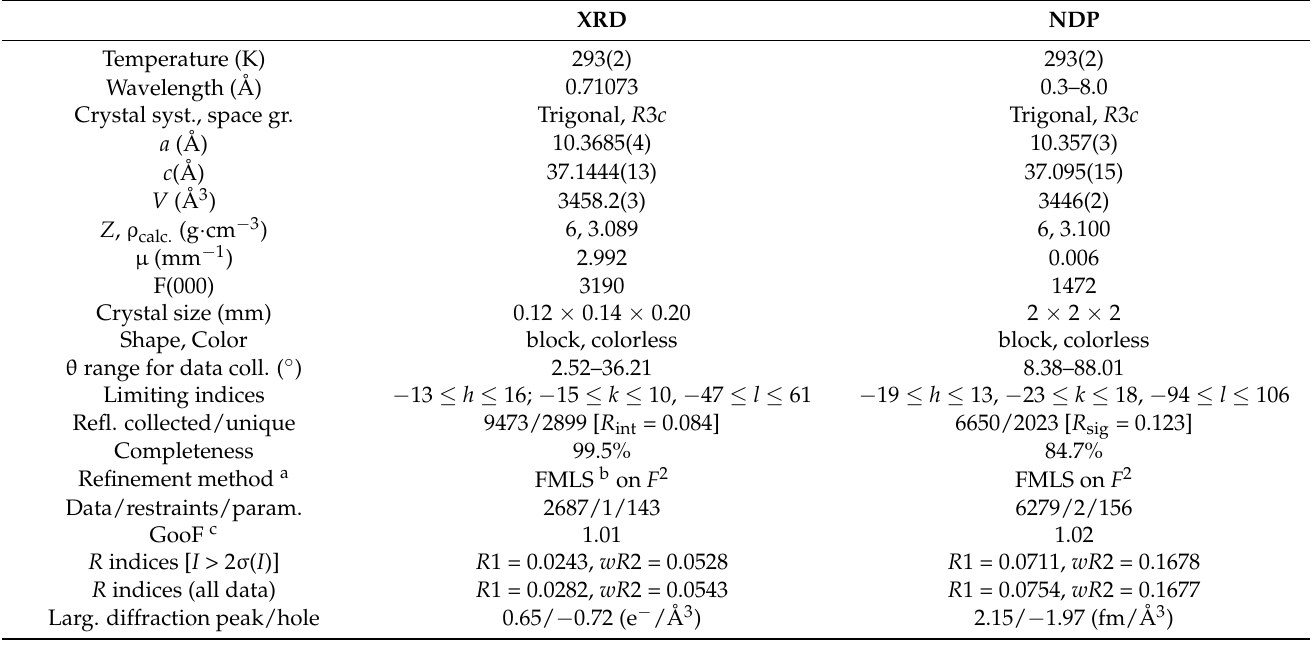
Table 2. Crystal data and structure refinement for whitlockite from Palermo Mine, USA. XRD